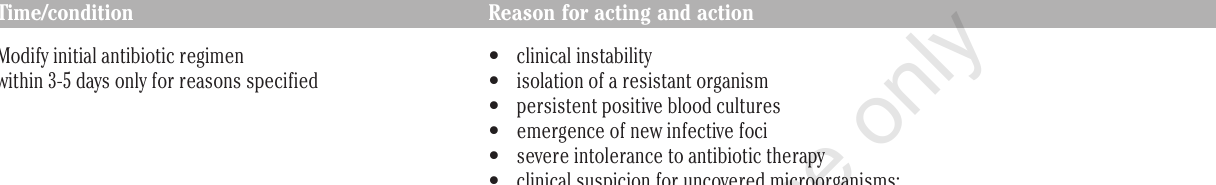
Table 5. Modification of empiric antibiotic therapy during the course of neutropenic fever.